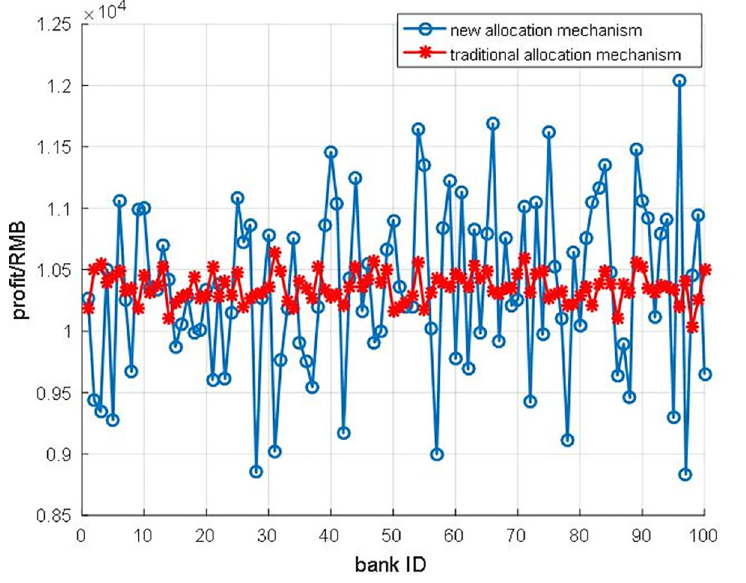
Fig 13. The comparison of bank profit for different allocation mechanism.